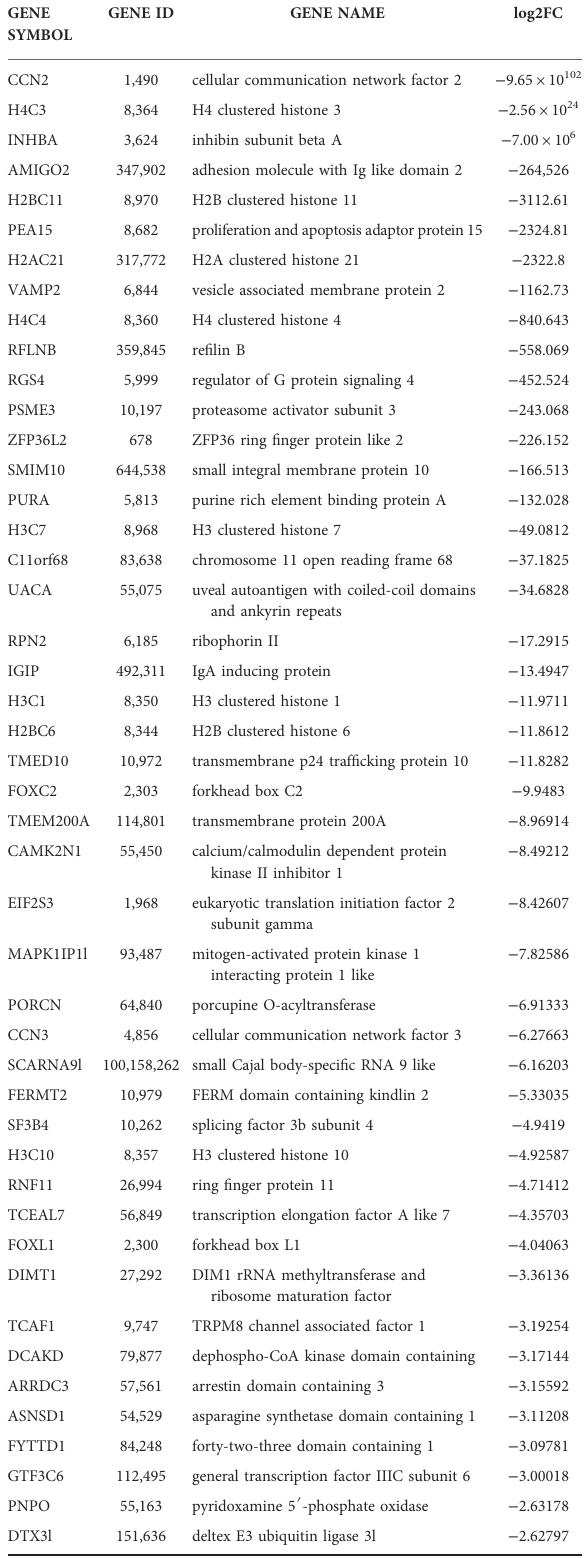
TABLE 2 Top 50 downregulated genes with>2 log2FC and ≤ 0.05 FDR in SRC-2 knockdown THESCs line. GENE